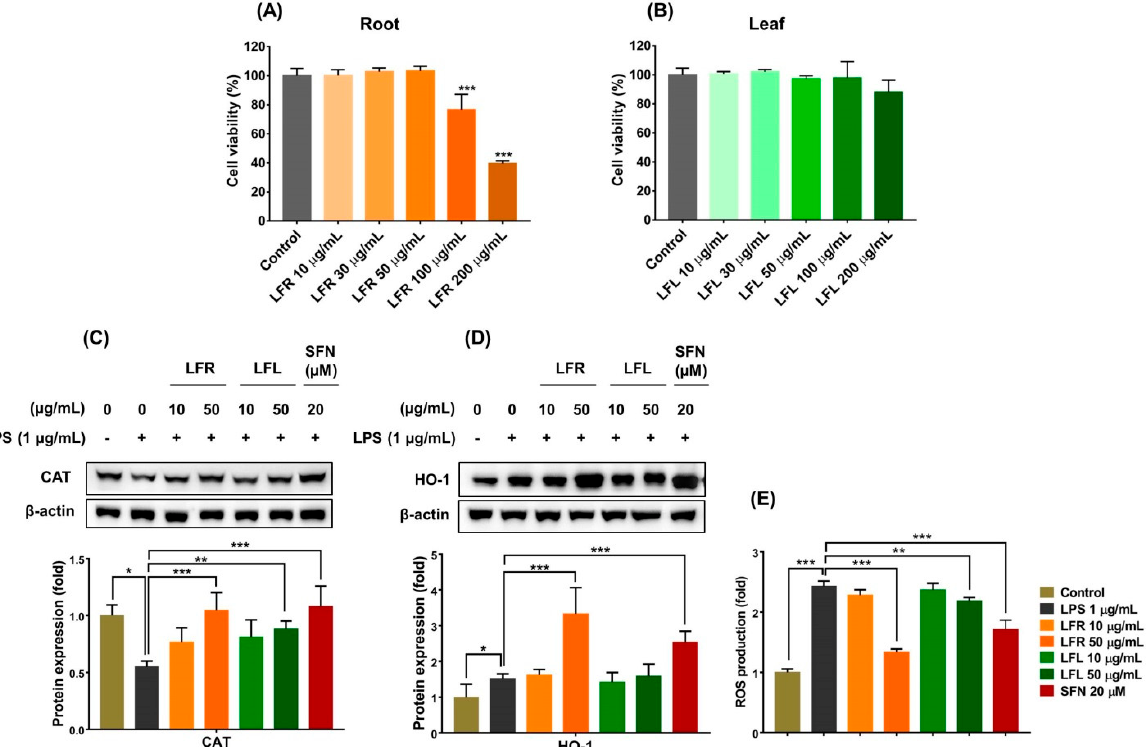
Figure 2. Cytotoxic effects and cell-based antioxidant activities of root and leaf extracts from L. fischeri . RAW 264.7 cells were incubated with various concentrations (10–200 µ g/mL) of root or leaf extracts for 24 h. The cell viability was measured using MTT assay. ( A , B ) Cell viability for root and leaf extracts, respectively. The RAW 264.7 cells were pretreated with LFR or LFL for 1 h prior to LPS (1 µ g/mL) incubation for an additional 12 h. ( C ) CAT expression. ( D ) HO-1 expression. ( E ) Intracellular ROS accumulation. Results are presented as the mean ± S.D. of at least three independent experiments. * p < 0.05, ** p < 0.01, and *** p < 0.001 are considered statistically significant differences. LFR and LFL: L. fischeri root and leaf extracts, respectively; SFN: sulforaphane; LPS: lip ‐ opolysaccharide.